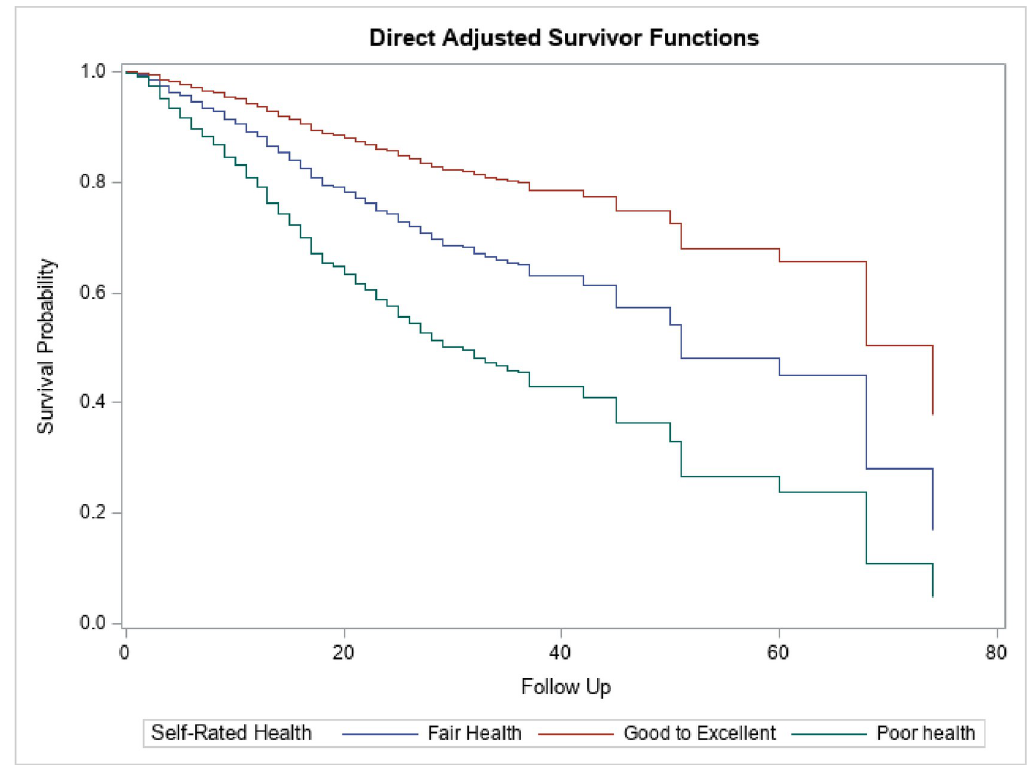
Fig 3. Cox-Proportional Hazard model stratified by symptoms of psychological stress. The median survival times among the population with poor self-rated health was 28 years (15 years, 60 years), fair self-rated health was 45 years (20 years, 74 years), and good self-rated health was 68 years (37 years, 68 years). The regression model was adjusted for age, race/ethnicity, educational attainment, marital status, poverty income ratio, health coverage, delayed appointment, usual place of care, affordable care, and year of